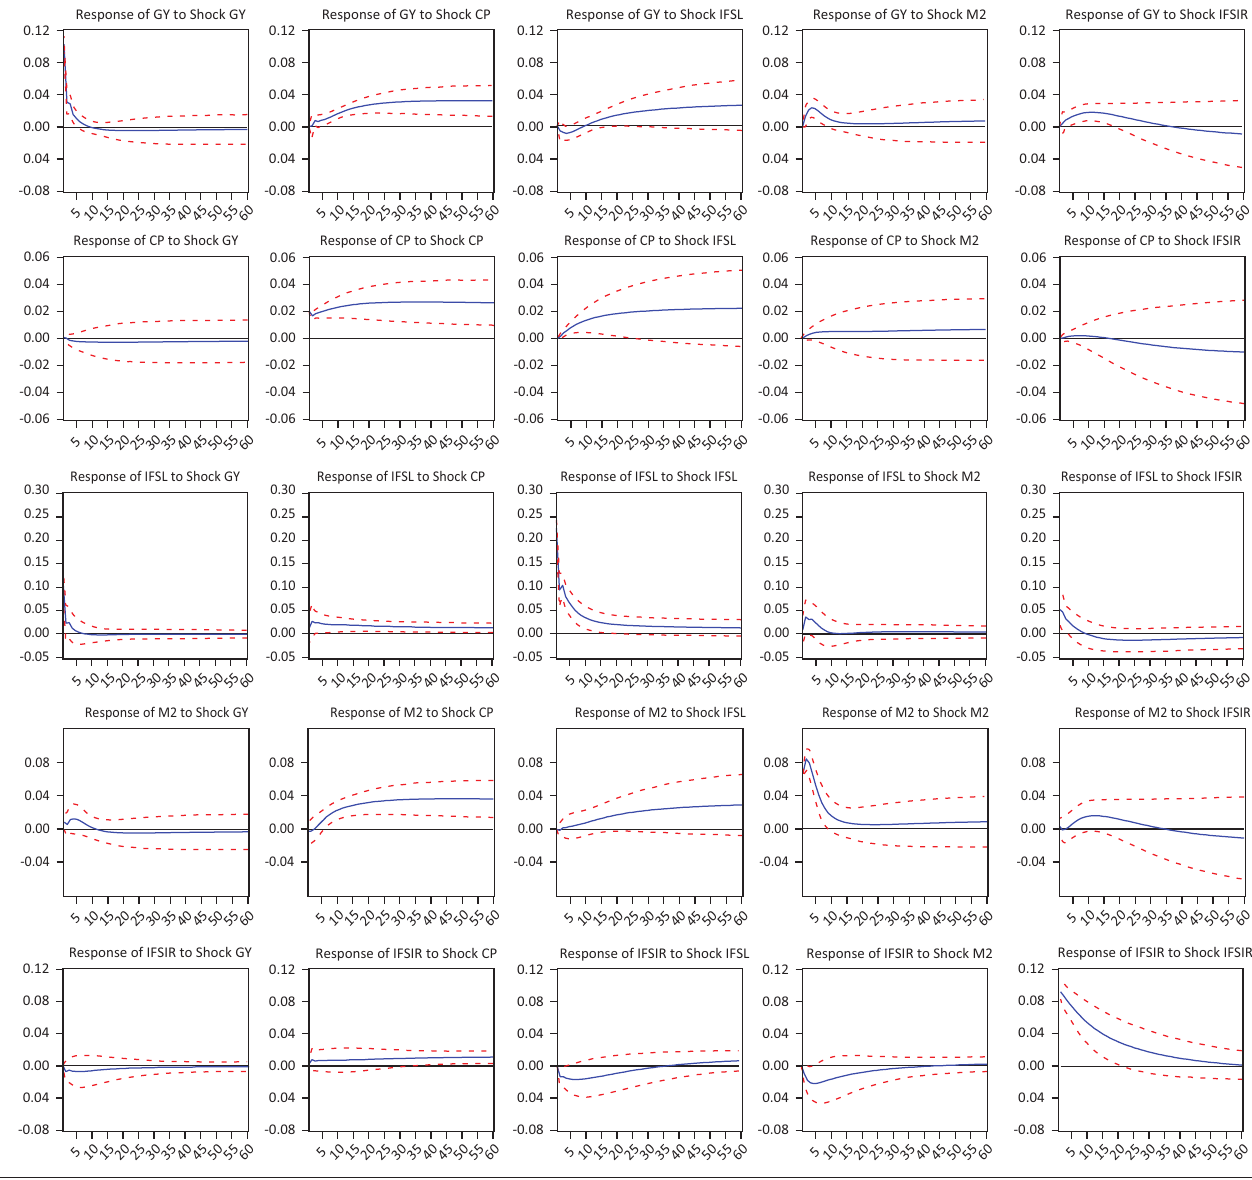
FIGURE 3-A1: Impulse responses with informal financial sector credit and interest